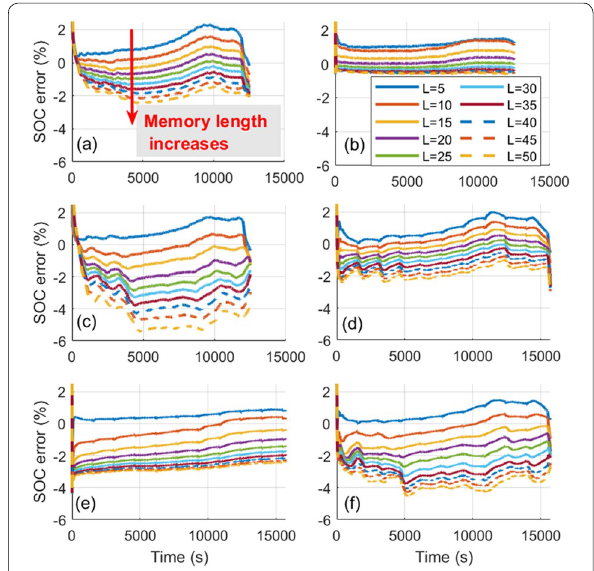
Figure 9 SOC estimation errors under different memory lengths: a R(RQ) for DST profile, b R(RWQ) for DST profile, c R(RQ) (RQ)W for DST profile, d R(RQ) for UDDS profile, e R(RWQ) for UDDS profile, f R(RQ) (RQ)W for UDDS